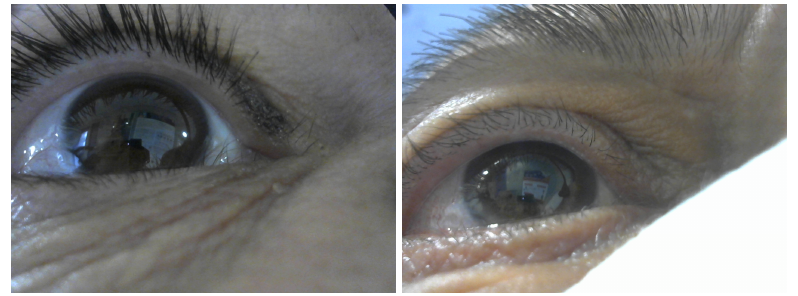
Figure 11. Sample images with dark iris